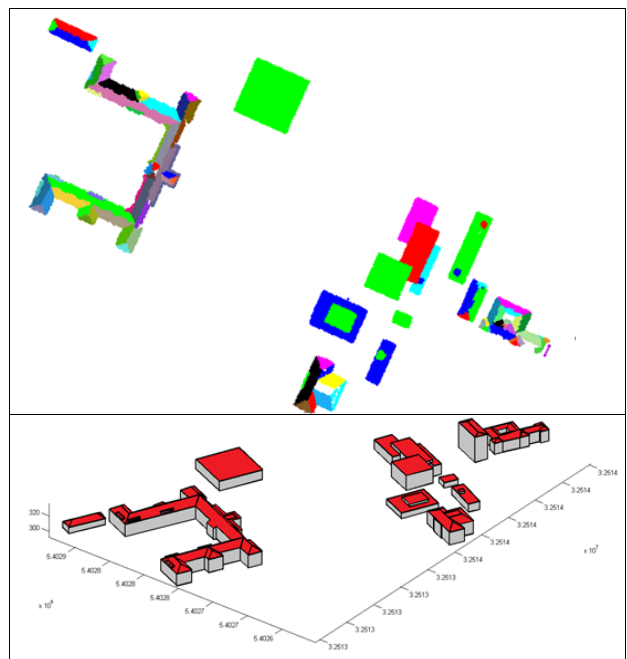
Figure 10. (Top) Segmentation results (Bottom) Reconstruction